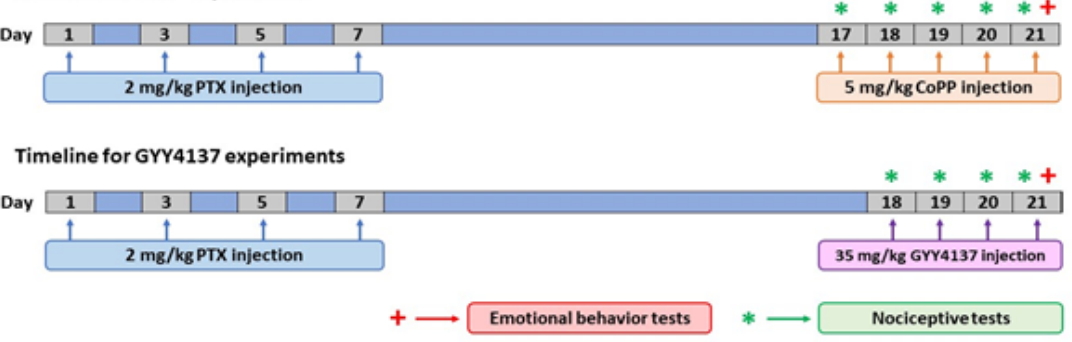
Figure 1 . Schematic illustration of the design of the experiment, performed to determine whether the repetitive administration of CoPP (5 mg/kg) or GYY4137 (35 mg/kg) intraperitoneally injected over 5 and 4 consecutive days, respectively, can reverse the nociceptive responses caused by PTX and the associated emotional disorders. PTX: paclitaxel.